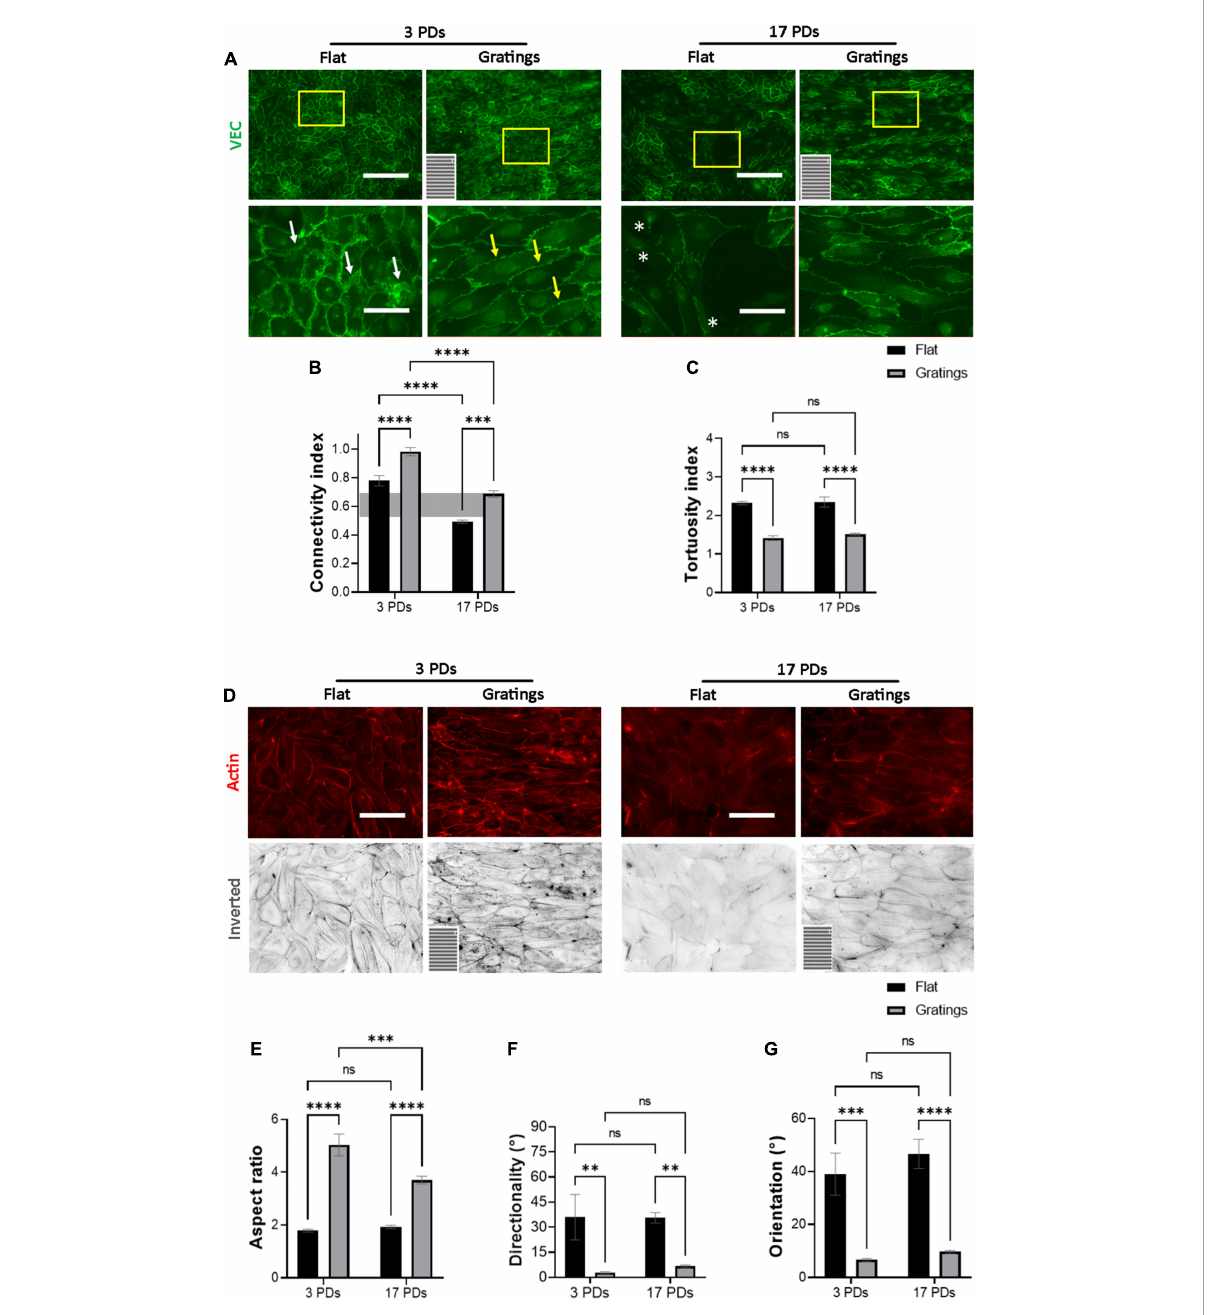
FIGURE4 Gratings restore the monolayer integrity of HUVECs. Representative immunofluorescence microscopy images for the analysis of monolayers of HUVECs after 3 and 17 PDs cultured either on a flat surface or on a micro-structured surface with gratings. (A) Cells stained with an antibody against VEC (green), white arrows indicate zipper-like junctions on a flat surface, while yellow arrows indicate linear junctions on a surface with gratings. White asterisks indicate signs of monolayer disruption on the flat surface. (B) Measure of normalized VEC-CI values in non-senescent (3 PDs) and senescent confluent monolayers (17 PDs) grown on a flat surface or on a surface with gratings. A horizontal gray bar indicates the threshold value that defines differentiated ECs and was measured in recently confluent endothelial monolayers after 3 PDs. (C) Tortuosity index in non-senescent (3 PDs) and senescent confluent monolayers (17 PDs) of ECs grown on a flat surface or on a surface with gratings. (D) Cells stained with an antibody against phalloidin (red). The orientation of the gratings is indicated on the panels in the lower left corner. Scale bars are 200 µ m (A) and 100 µ m (B) . (E) Aspect ratio of HUVECs defined as the ratio of major- to minor-axis length. (F) Average directionality of actin filaments in degrees relative to the orientation of the gratings. (G) Average cell orientation relative to the orientation of the gratings. In (B,C,E–G) , data represent the mean and standard error of the mean of 3 donors with more than 100 cells per condition. ∗ p < 0.05; ∗∗ p ≤ 0.01; ∗∗∗ p ≤ 0.001; ∗∗∗∗ p ≤ 0.0001; ns, not